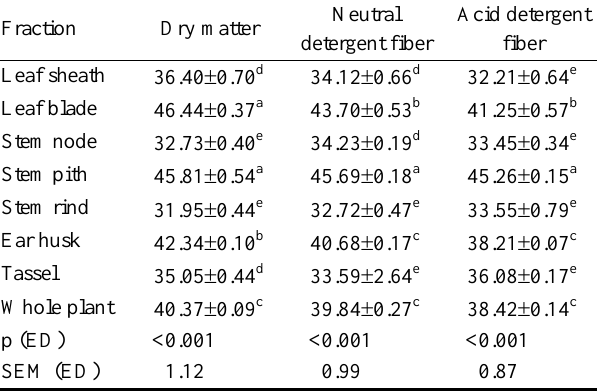
Table 5. The effective degradability (ED, %) of dry matter, neutral detergent fiber, and acid detergent fiber of whole corn stover and different morphological fractions